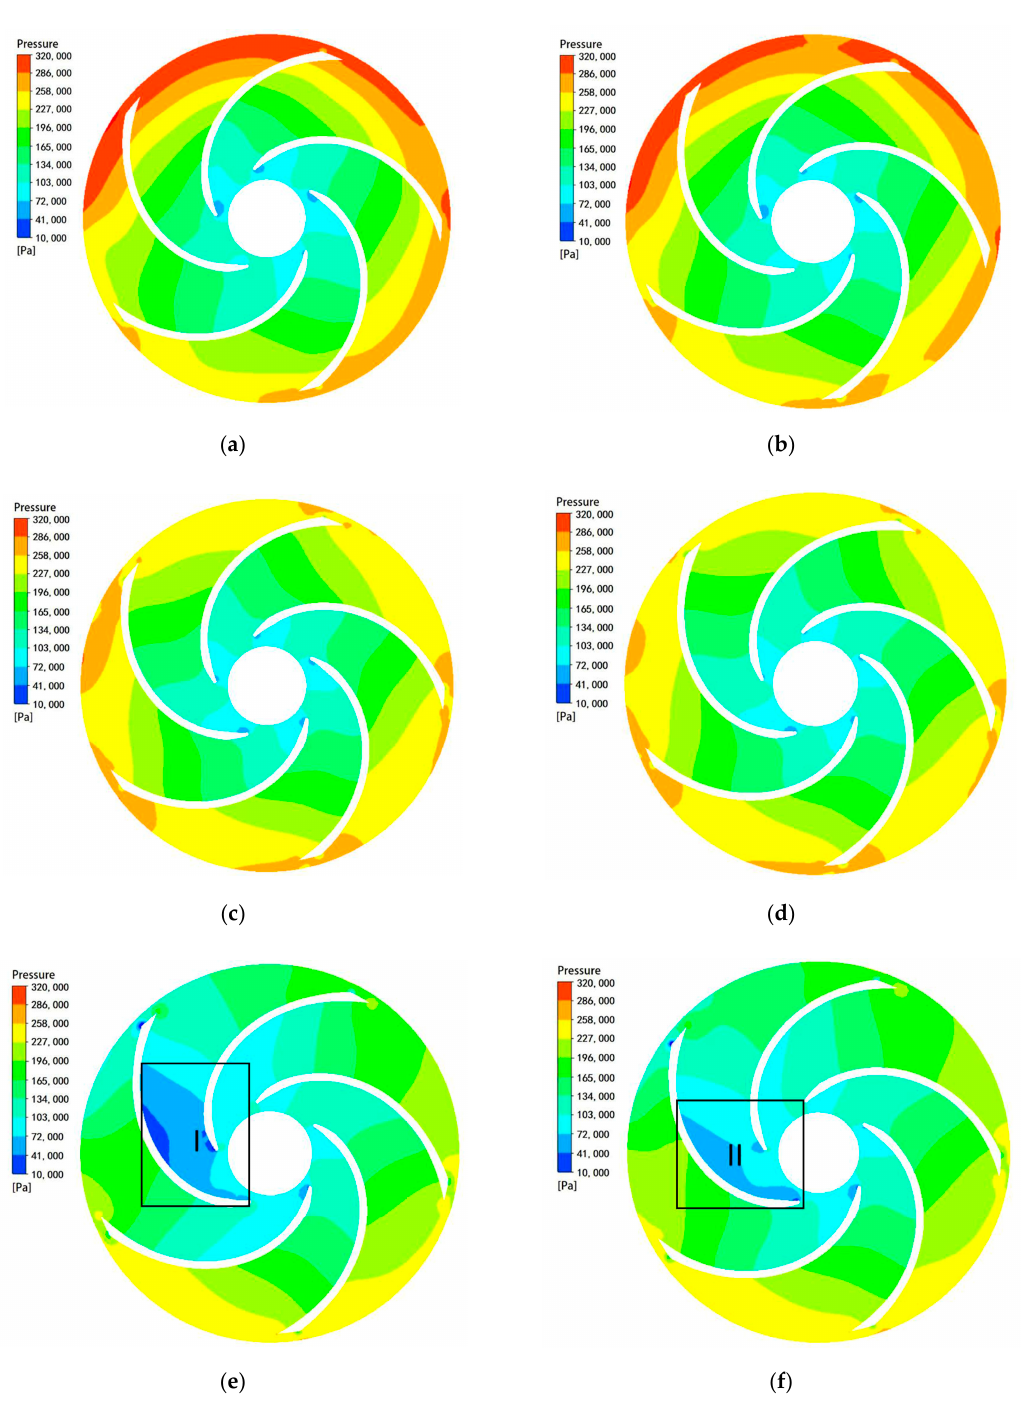
Figure 10. Pressure distributions in impeller of original and optimal pump. ( a ) 0.6 Q d (original ); ( b ) 0.6 Q d (optimal ); ( c ) 0.8 Q d (original ); ( d ) 0.8 Q d (optimal ); ( e ) 1.0 Q d (original ); ( f ) 1.0 Q d (optimal ).